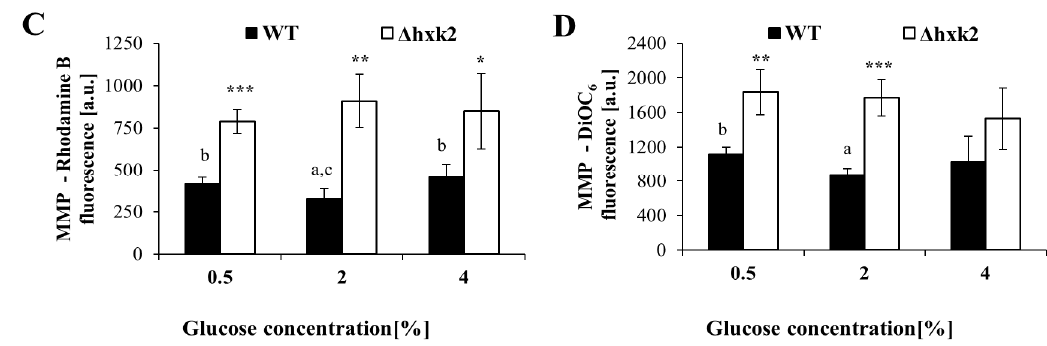
Figure 3. Mitochondrial membrane potential and morphology of the mitochondrial network of yeast cells from the early exponential phase of growth cultured in different metabolic conditions. ( A ) Morphology of the mitochondrial network and ( C ) mitochondrial membrane potential (MMP) determined using rhodamine B hexyl; ( B ) morphology of the mitochondrial network and ( D ) MMP determined using DiOC 6 (3). The fluorescence was measured at λ ex = 555 nm and λ em = 579 nm for rhodamine B or at λ ex = 476 nm and λ em = 501 nm for DiOC6(3). The results are presented as mean ± SD from three independent experiments. * p < 0.05, ** p < 0.01, *** p < 0.001 as compared to the WT strain; a—different to medium with 0.5% glucose, b—different to medium with 2% glucose, c—different to medium with 4% glucose. Mitochondrial network was visualized using fluorescence microscope Olympus BX-51 equipped with the DP-72 digital camera and cellSens Dimension v1.0 software at appropriate wavelengths. The microscopic images present typical results from of the duplicate experiment. Magnification 100×.